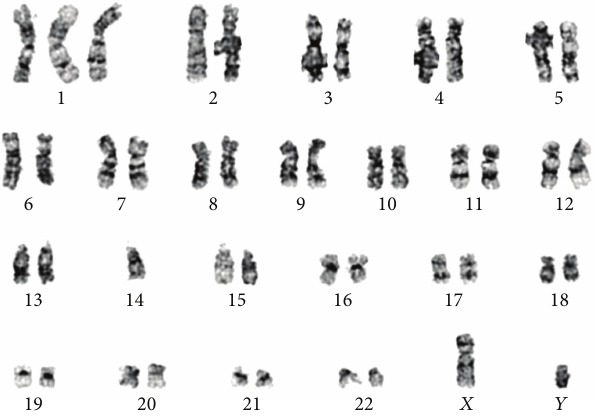
Figure 2: Representative G-banded karyogram showing 46,XY,+1,